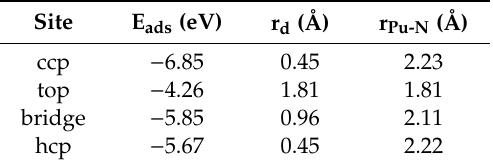
Table 2. Adsorption energies of atomic nitrogen adsorption onto PuH 2 (111) surface. Adsorption parameter r d is the vertical distance from the surface and and r Pu-N is the average distance of